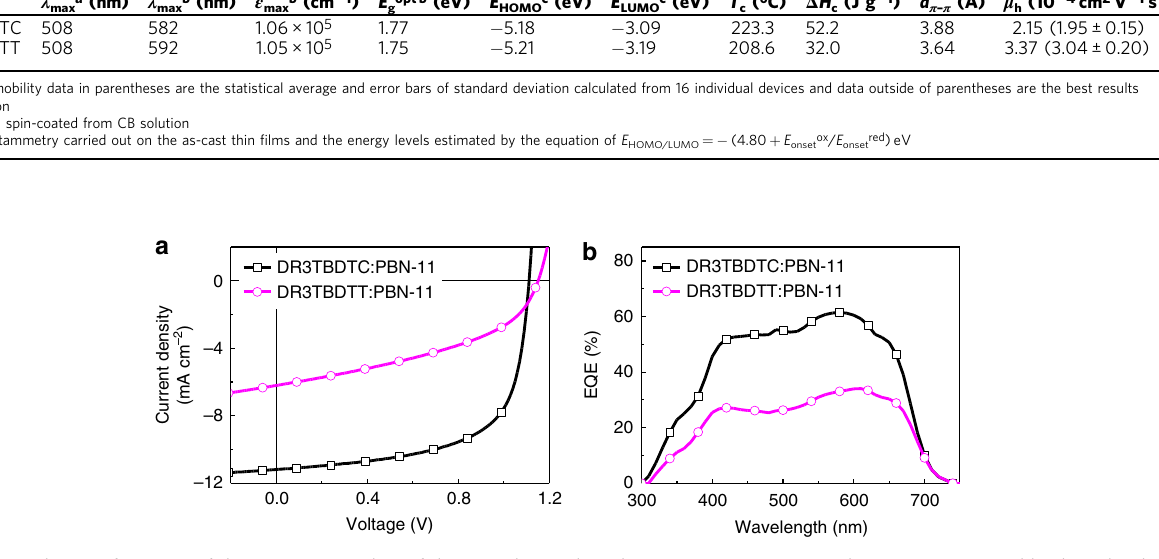
Table 1 The optical, electrochemical, thermal properties, π – π stacking distance and hole mobility of DR3TBDTC and DR3TBDTT Donors